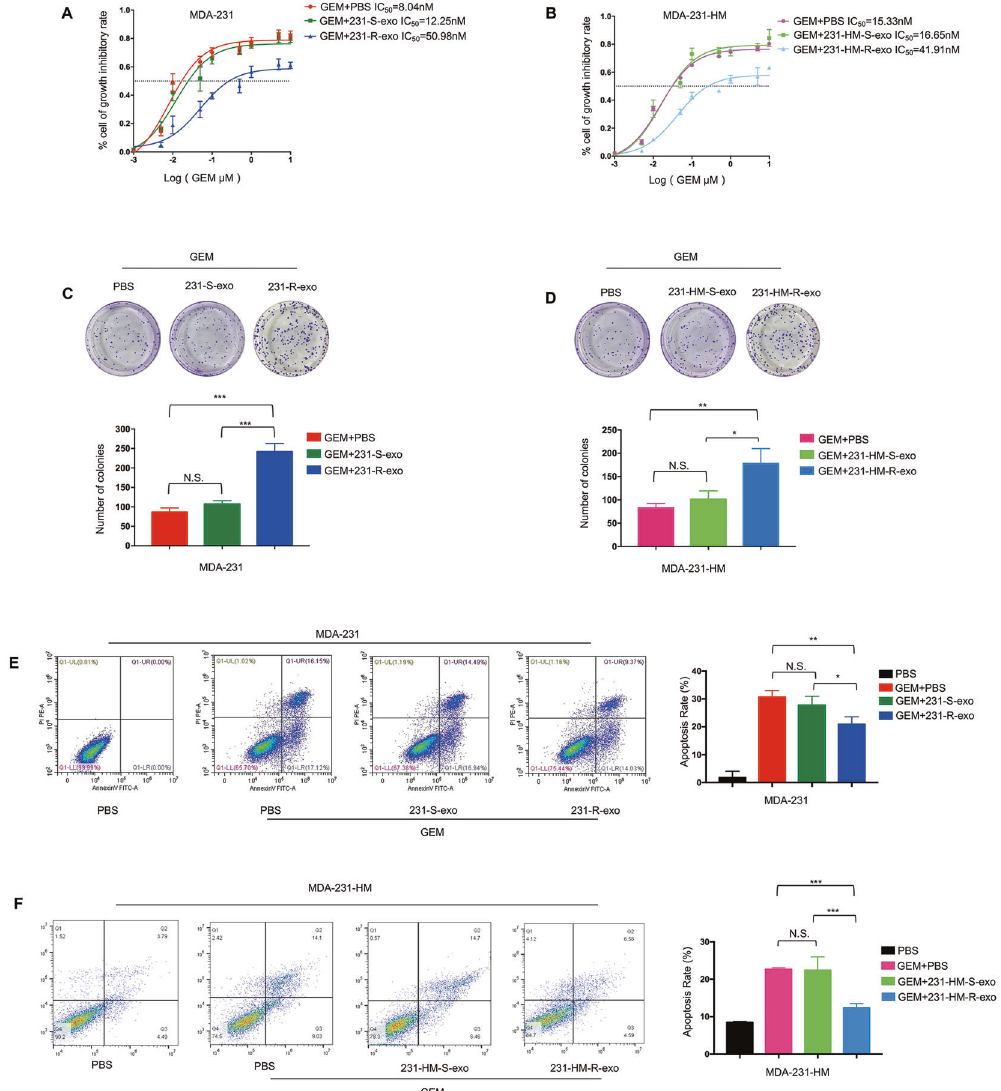
Fig. 1 Exosomes derived from resistant cells enhance gemcitabine (GEM) resistance in triple-negative breast cancer. A , B IC 50 values determined using the CCK-8 assay in MDA-231 and MDA-231-HM cells treated with GEM + PBS, GEM + sensitive cell-derived exosomes (231-S- exo or 231-HM-S-exo), and GEM + resistant cell-derived exosomes (231-R-exo or 231-HM-R-exo) for 48 h. All experiments were repeated three times, and the representative results are presented. C , D Colony formation analysis in MDA-231 and MDA-231-HM cells treated with GEM + PBS, GEM + sensitive cell-derived exosomes (231-S-exo or 231-HM-S-exo), or GEM + resistant cell-derived exosomes (231-R-exo or 231-HM-R- exo) for 24 h and incubated for 7 days. E , F Flow cytometric analyses of apoptotic cells in MDA-231 and MDA-231-HM cells treated with PBS, GEM + PBS, GEM + sensitive cell-derived exosomes (231-S-exo or 231-HM-S-exo), or GEM + resistant cell-derived exosomes (231-R-exo or 231- HM-R-exo) for 24 h. Quantitative data are presented as the mean ± SD of triplicate experiments. * P < 0.05, ** P < 0.01, *** P < 0.001, and **** P <